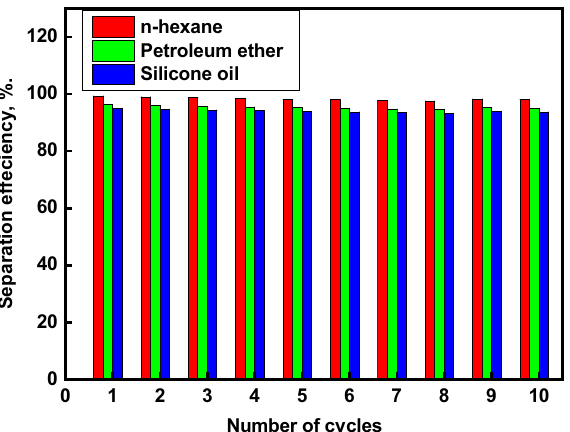
Figure 9. Separation efficiency of the modified textile fabric for different oil/water mixtures with the number of separation